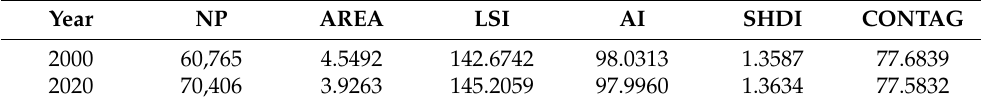
Table 2. Landscape pattern index of the entire Hexi Corridor.